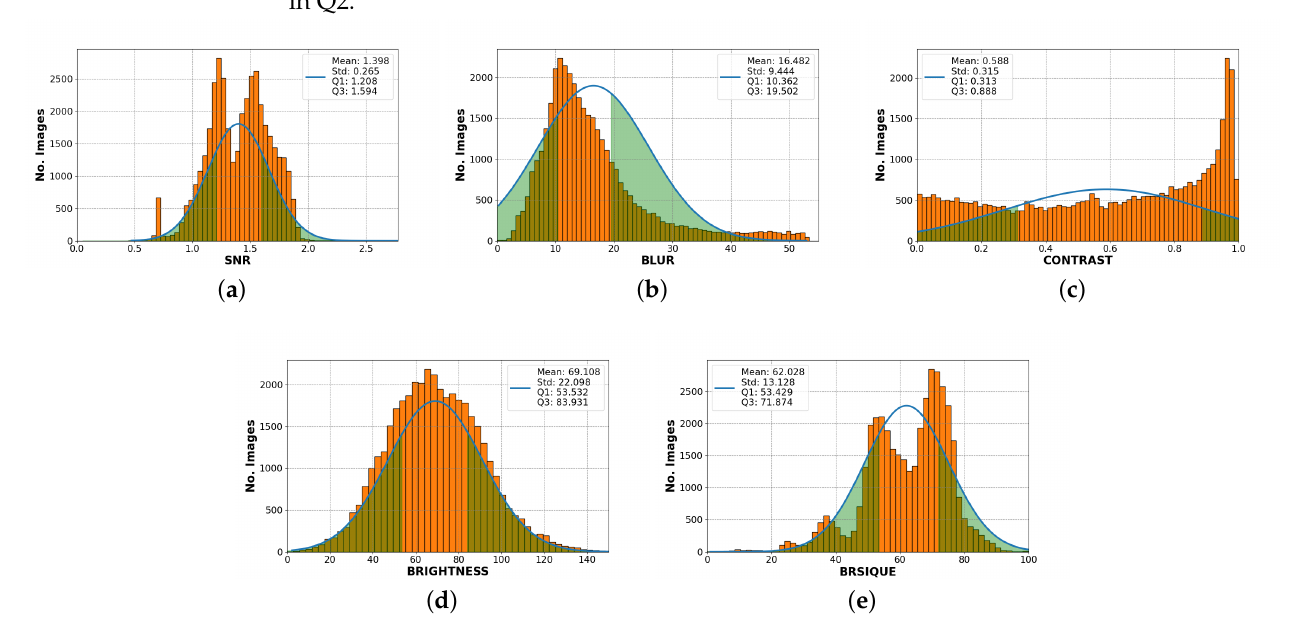
Figure 8. Histogram display of each standard feature fitted to Gaussian curve. ( a ) The signal-to-noise ratio has two peaks in quartile 1 (Q1) and quartile 3 (Q3), with a mean of 1.398. ( b ) Blur has a high element concentration in Q1 with 10,362. ( c ) The contrast has a uniform distribution. ( d ) The brightness fits the Gaussian distribution. ( e ) BRISQUE has two peaks in Q1 and Q3. However, the highest concentration of elements is below the